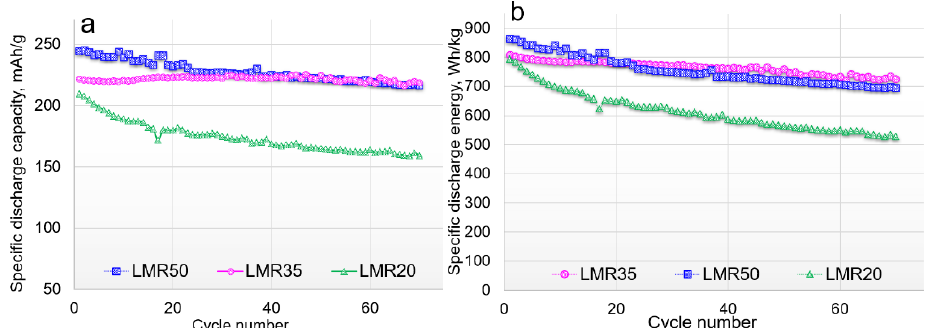
Figure 7. Cycling behavior of cathode materials at 20 mA/g: ( a ) discharge capacity vs. cycle number, ( b ) discharge energy vs. cycle number.